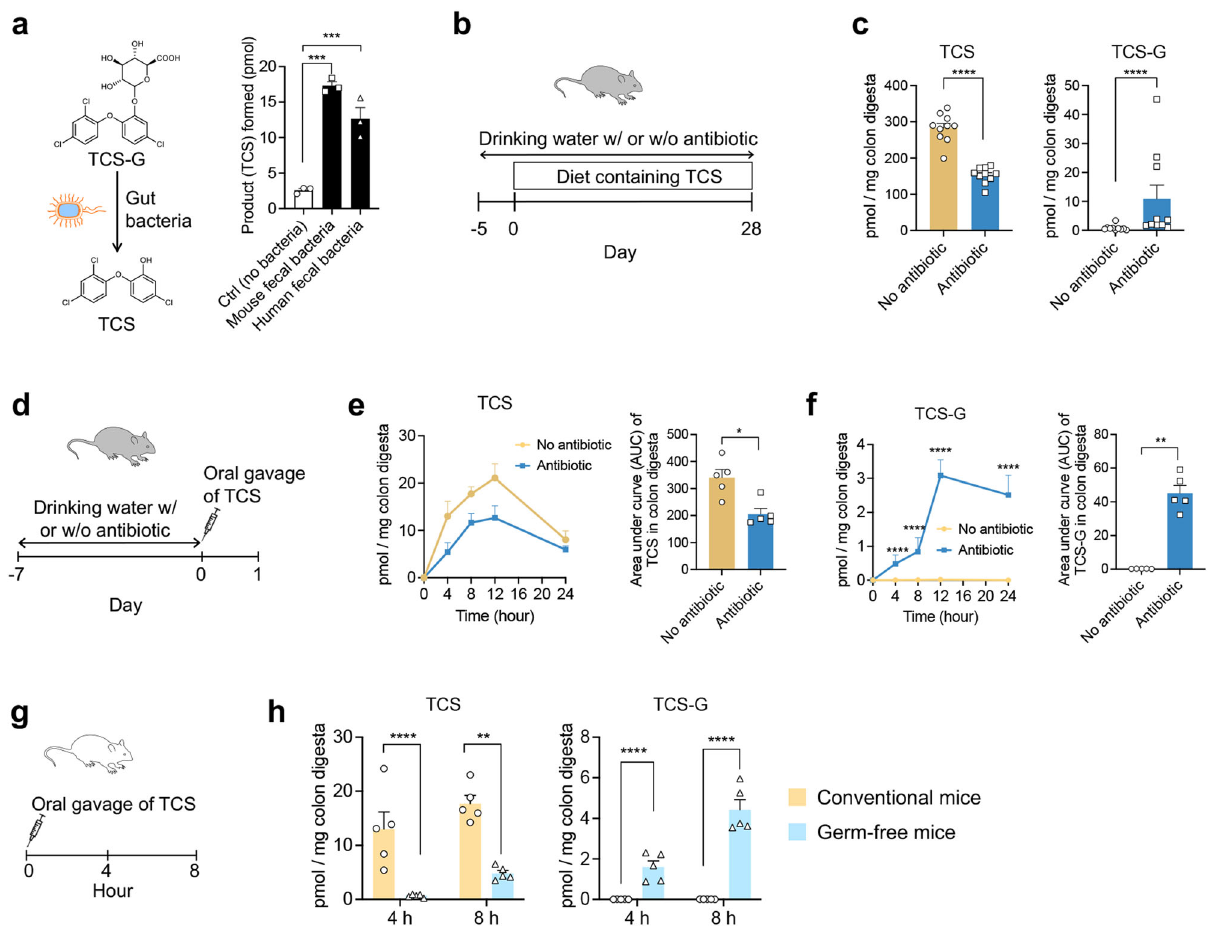
Fig. 2 Gut bacteria convert TCS-G to TCS in vitro and in vivo. a Fecal bacteria from mice and humans convert TCS-G to TCS in vitro ( n = 3 per group).